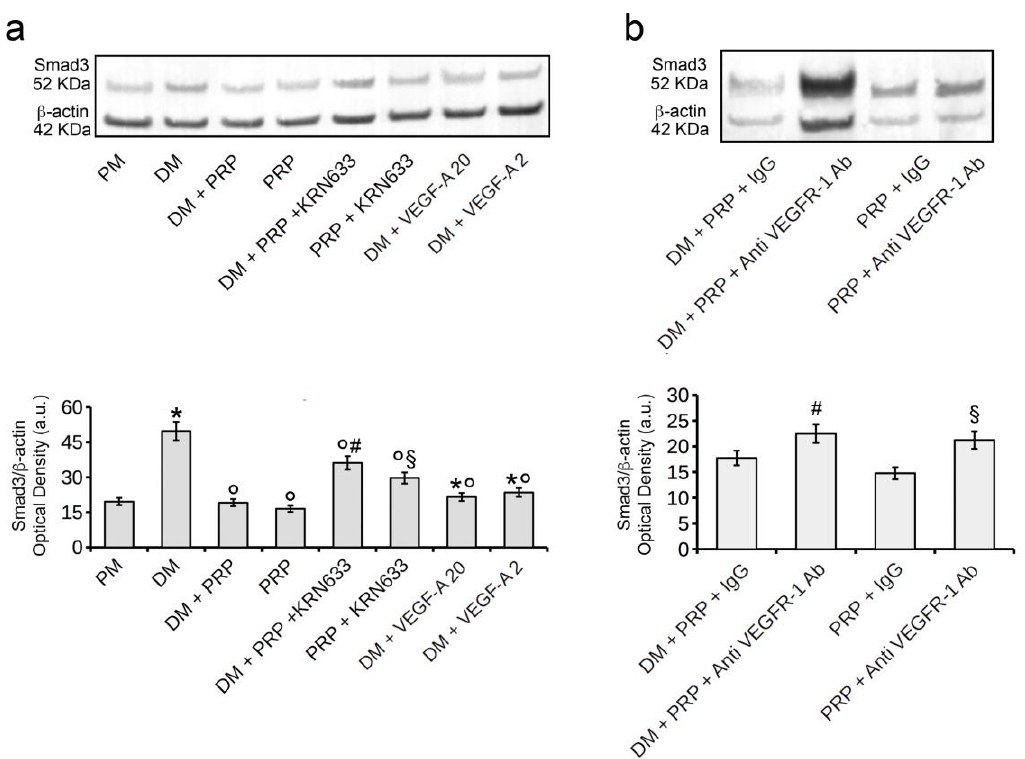
Figure 7. Western blotting analysis of Smad3 expression. ( a ) NIH/3T3 fibroblastic cells were cultured in differentiation medium (DM, low serum medium plus 2 ng/mL TGF- β 1) in the absence or presence of 1:50 diluted PRP (DM + PRP) or in the presence of 1:50 serum-free medium diluted PRP (PRP). To evaluate the involvement of VEGF-A/VEGFR-1 mediated signaling in the PRP-induced fibroblast response, the cells were treated with the selective pharmacological VEGFR inhibitor, KRN633 (DM + PRP + KRN633; PRP + KRN633). In parallel experiments the cells were cultured in DM in the presence of two different concentrations of soluble VEGF-A (20 ng/mL, DM + VEGF-A 20; 2 ng/mL, DM + VEGF-A 2). Cells that were cultured in proliferation medium (PM) served as control undifferentiated cells. ( b ) The cells were cultured in DM + PRP or PRP alone in the presence of irrelevant isotype-matched IgG (DM + PRP + IgG; PRP + IgG) or anti-VEGFR-1 neutralizing antibodies (8 µ g/mL; DM + PRP + Anti VEGFR-1 Ab; PRP + Anti VEGFR-1 Ab. Representative western blots of Smad3 and β -actin expression are shown. Histograms show the densitometric analysis of the bands normalized to β -actin. Data shown are mean ± S.E.M. and represent the results of at least three independent experiments performed in triplicate. Significance of difference: in ( a ), * p < 0.05 vs. PM; ◦ p < 0.05 vs. DM; # p < 0.05 vs. DM + PRP; § p < 0.05 vs. PRP; in ( b ), # p < 0.05 vs. DM + PRP + IgG; § p < 0.05 vs. PRP + IgG.